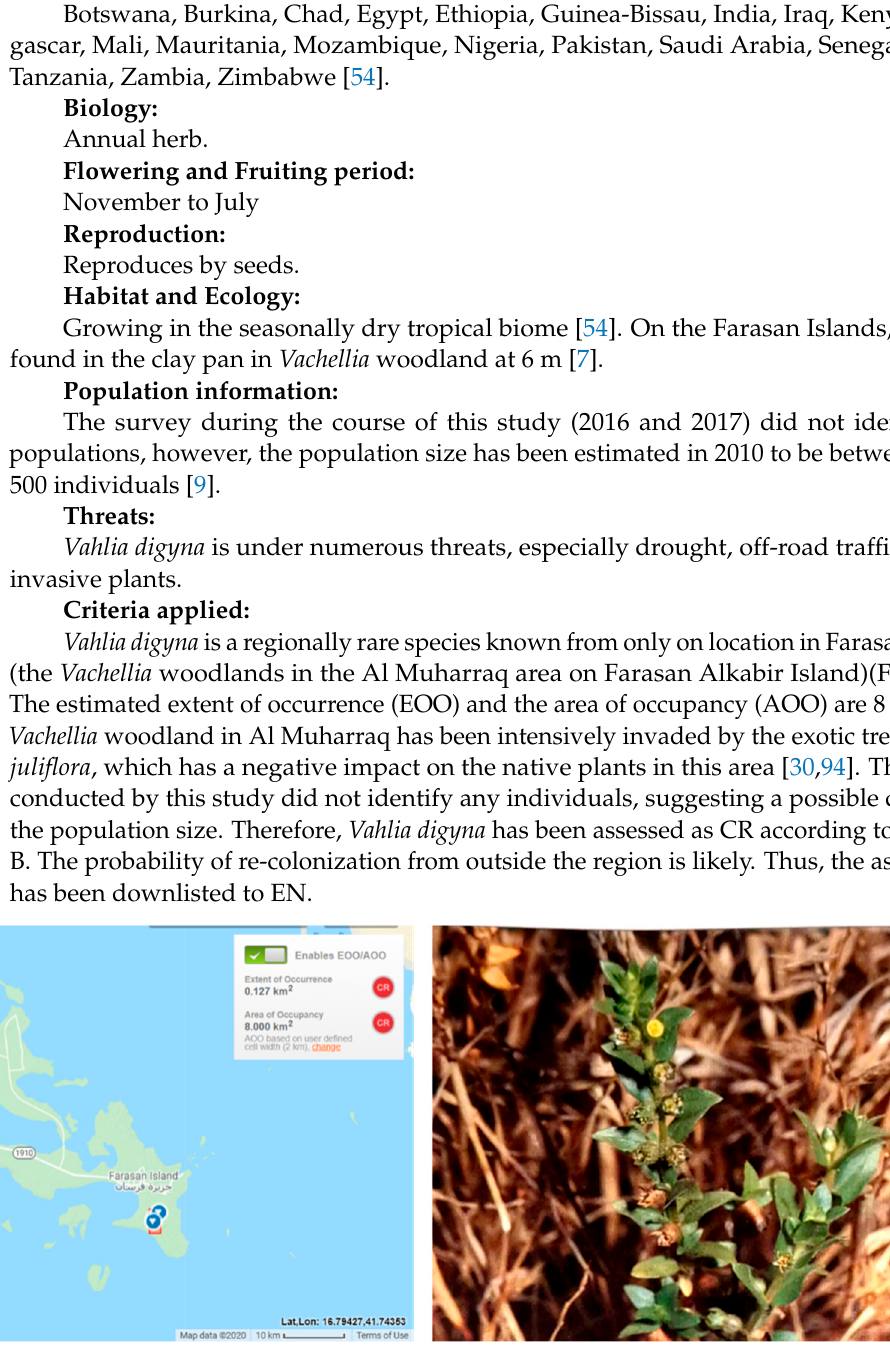
Figure 14. Geographical distribution of Vahlia digyna in the Farasan Archipelago. Plant photo reproduced with permission from Collenette [7] .